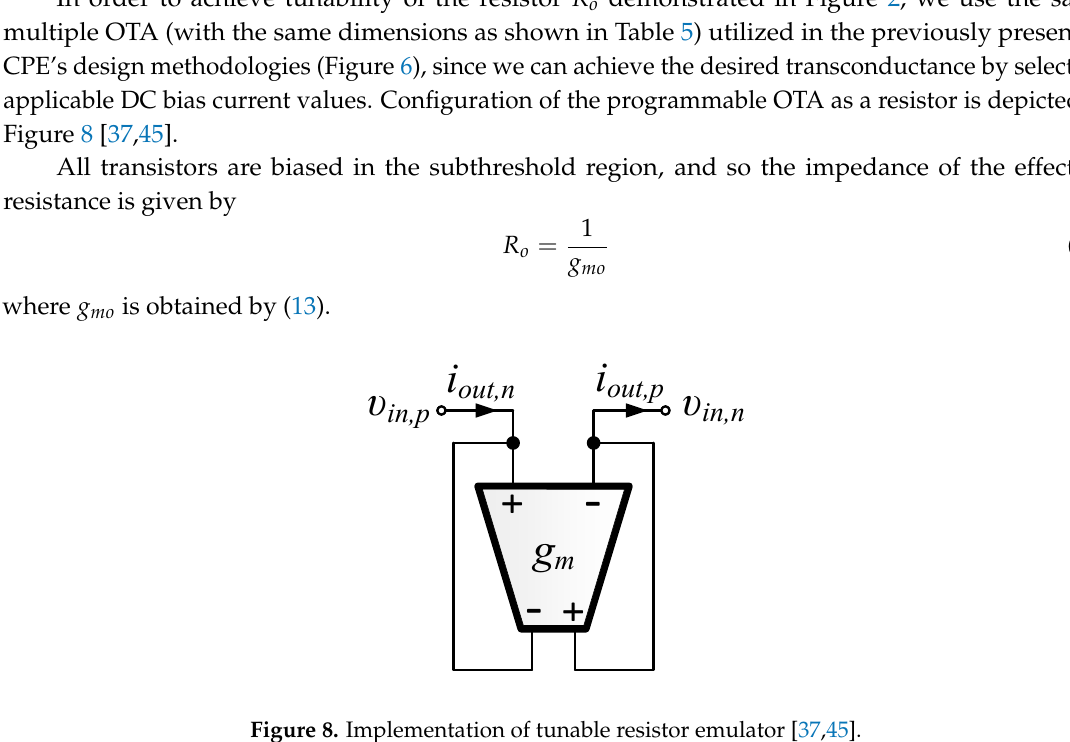
Figure 8. Implementation of tunable resistor emulator